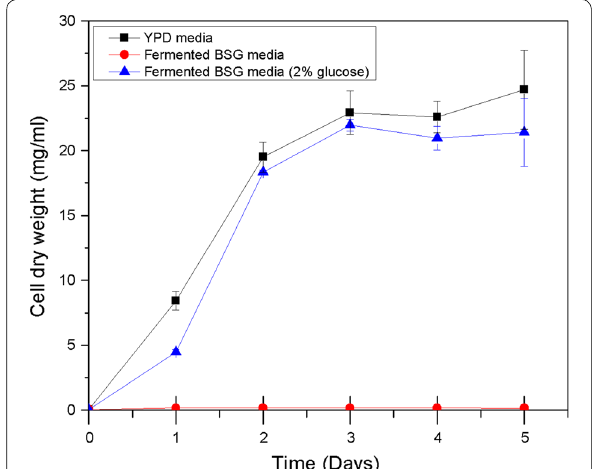
Fig. 2 Growth curves for R. toruloides when grown in YPD, Fermented BSG and Fermented BSG (2% w/w glucose) media represented as cell dry weight (mg/ml) vs. time